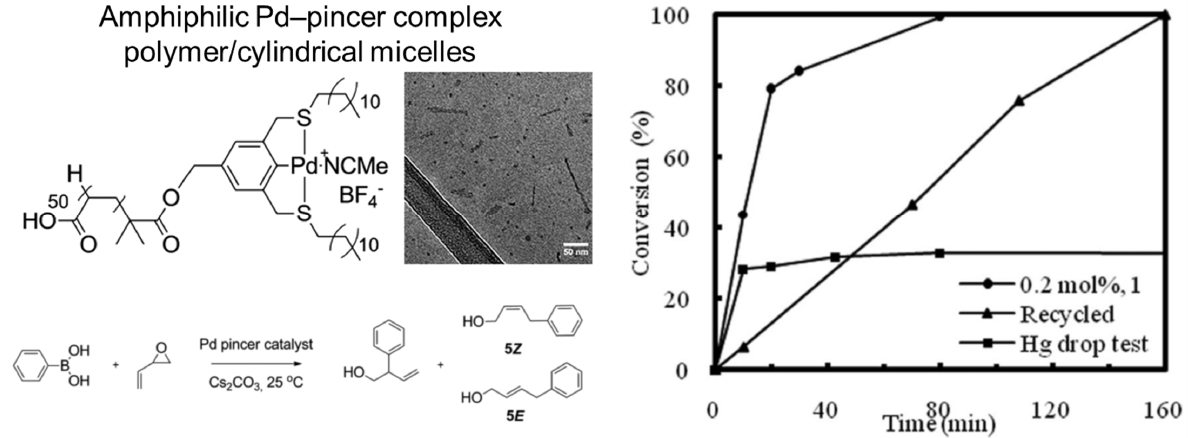
Figure 5. Amphiphilic polymer bearing an SCS pincer palladium complex synthesized by reversible addition fragmentation chain-transfer (RAFT) polymerization. The resulting amphiphile self-assembled into cylindrical (worm-like) micelles in water. The resulting catalyst was used for cross coupling of vinyl epoxide with phenyl boronic acid to afford branched and linear alcohols. The reaction was completed with 0.2 mol% catalyst (100% conversion) after ca. 80 min. Degradation of the catalyst was observed upon recycling of the catalyst and with the addition of Hg(0) (which selectively binds Pd(0)). Adapted from [99] with